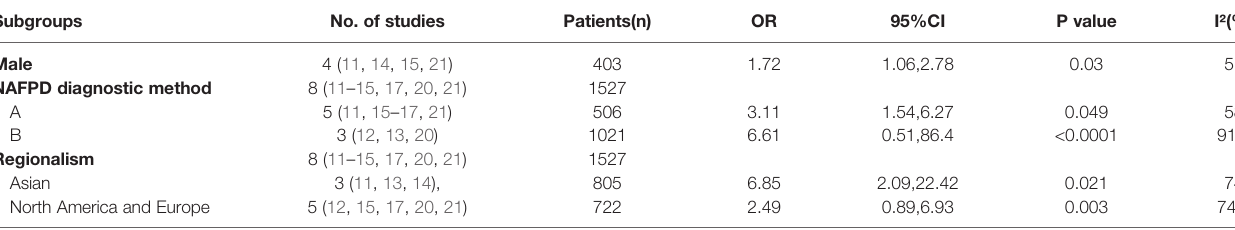
TABLE 2 | Subgroup analysis for the association association between FP and POPF.